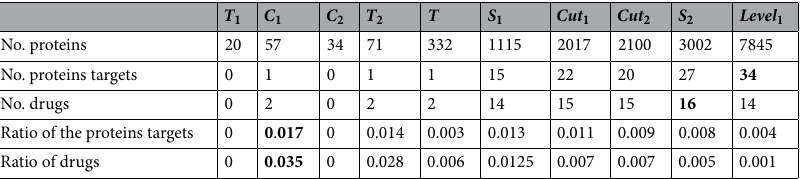
Table 3. The summary of drug targets and related drugs for Covid-Drug group. The first row shows the size of T C C T S Cut Cut S Level 1 , 1 , 2 , 2 , T , 1 , 1 , 2 , 2 , 1 sets. The number of proteins targets and related drugs in each set for Covid-Drug group are reported in second and third rows, respectively. The fourth and fifth rows show the ratio of the number of proteins that targeted and their related drugs in each set for Covid-Drug group to the size of sets, respectively. The complete description of sets is presented in Table 1. Best results are indicated in bold.